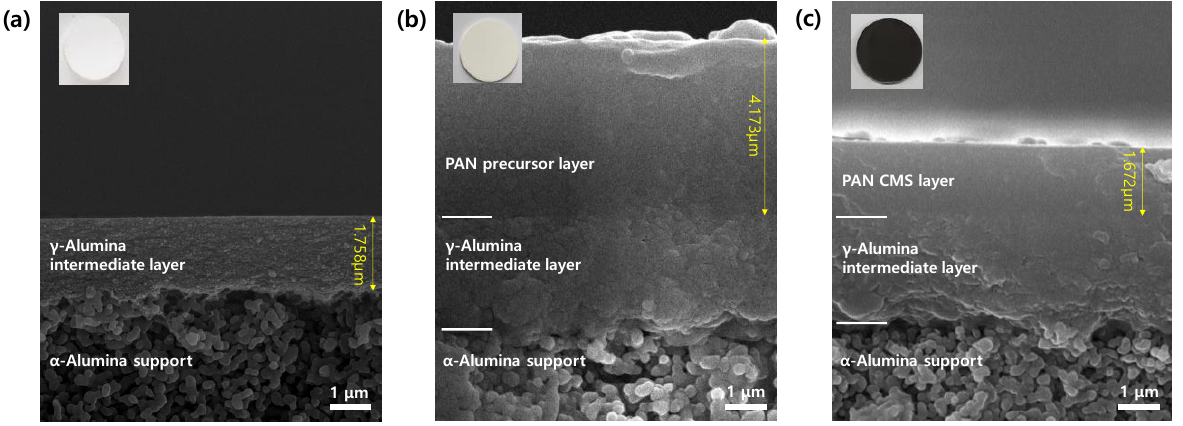
Figure 3. Cross-sectional SEM images of ( a ) alumina intermediate layer-coated membrane, ( b ) PAN polymer-coated membrane, and ( c ) CMS composite membrane (stabilization: 250 °C (temperature), and 1 h (soaking time); pyrolysis: 550 °C (temperature), 8.33 °C/min (heating rate), and 1 h (soaking time) .